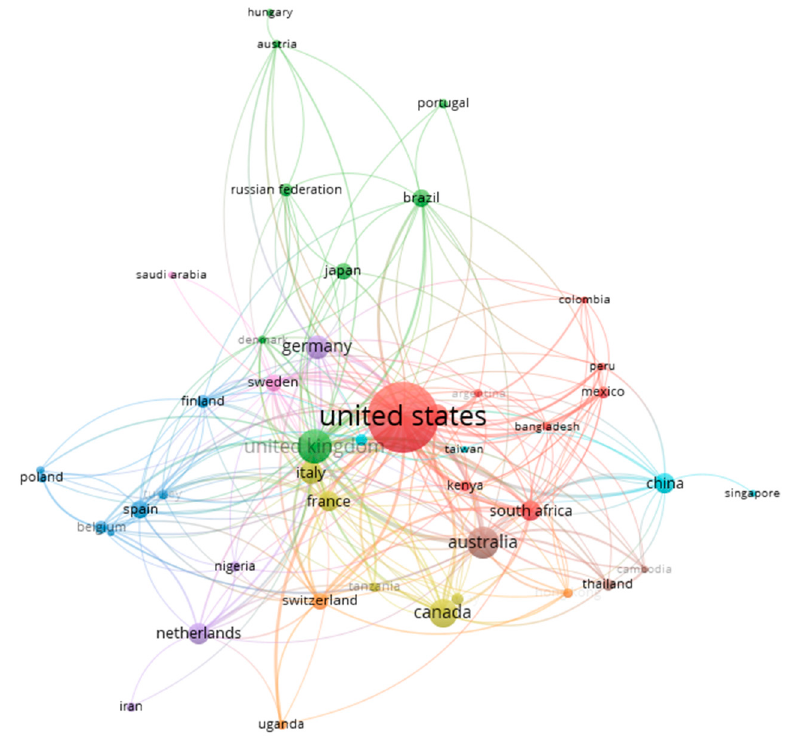
Figure 3. Collaboration among countries.